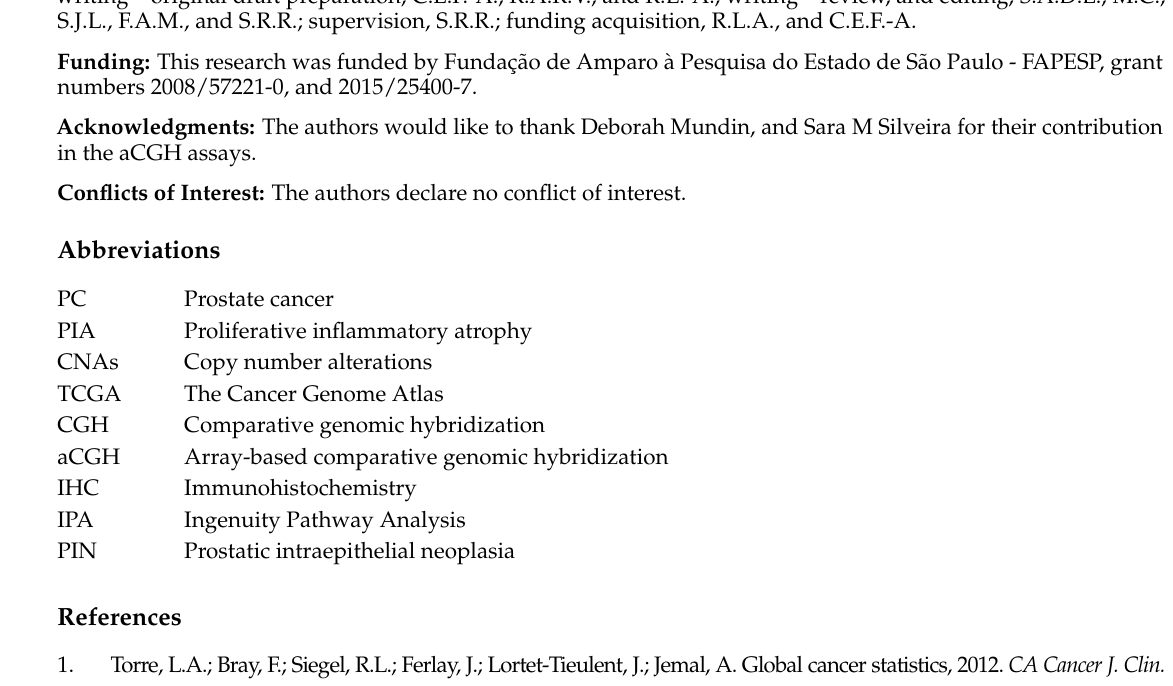
generated by IPA